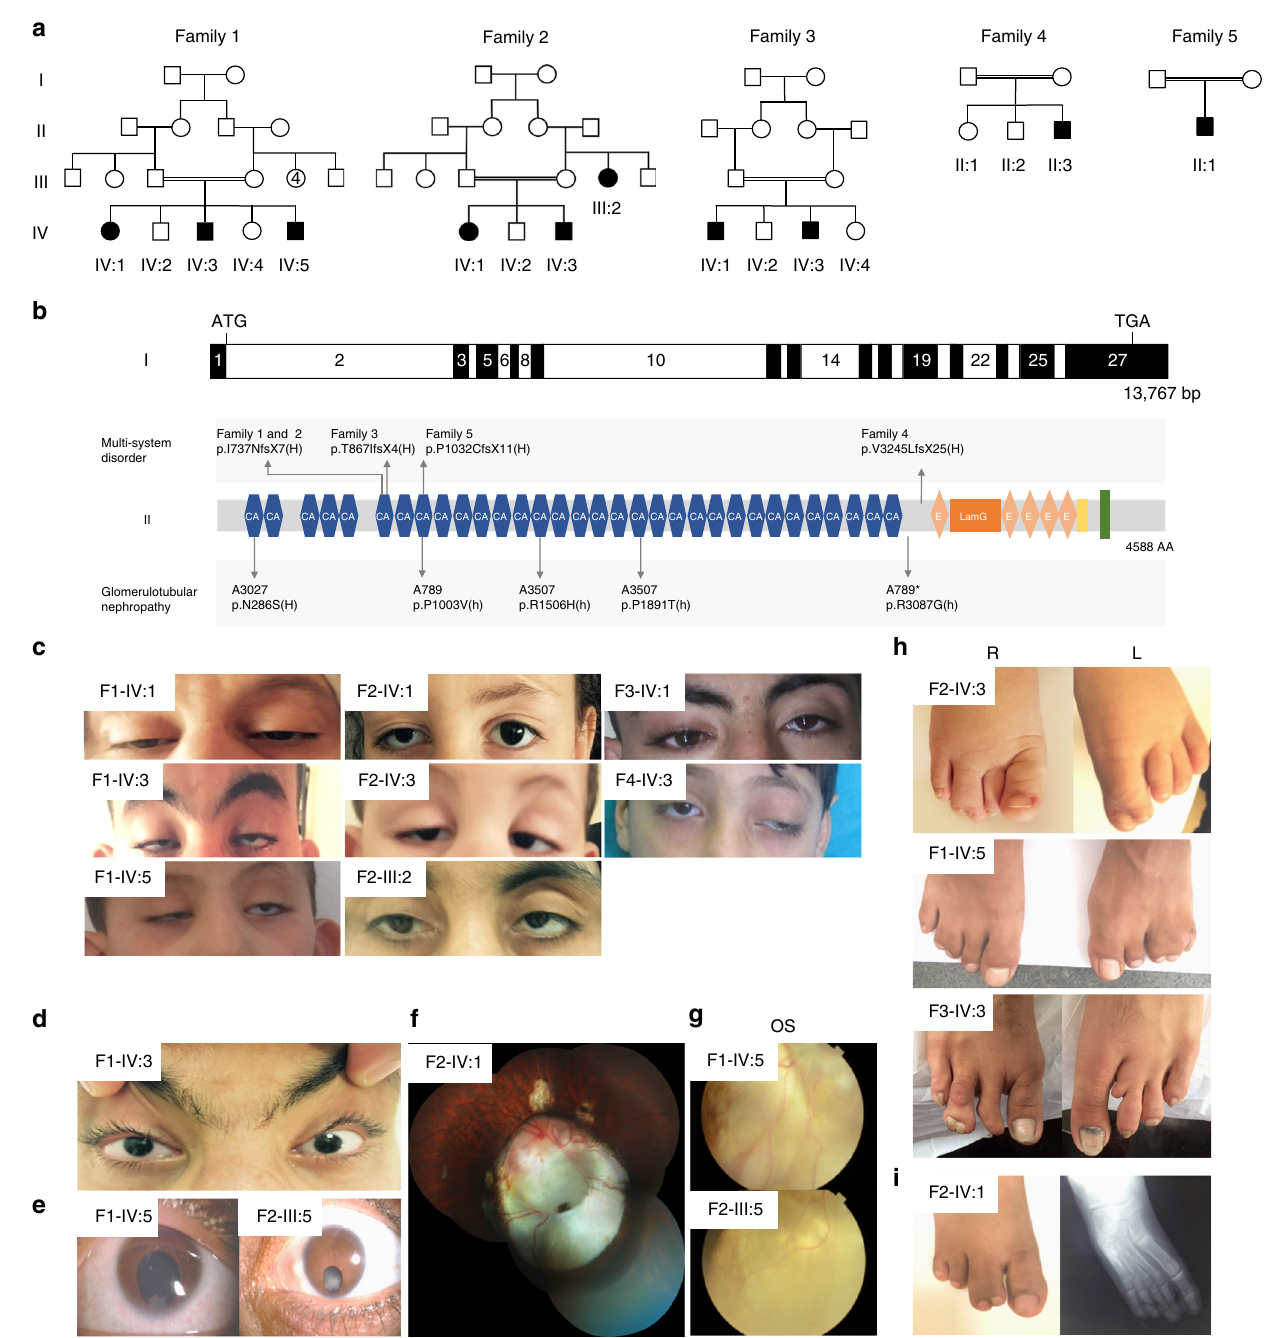
Fig. 1 Recessive frameshift mutations in FAT1 cause a new clinical syndrome. Pedigree of family 1 – 5 ( a ). A schematic of human FAT1 start/stop codon, exons, location of mutations previous published and identi fi ed in this study (top panel). The FAT1 protein is 4588 amino acids long and contains 34 cadherin repeats (CA), followed by fi ve epidermal growth factor (EGF)-like repeat domains (E), a laminin G domain (LamG), a transmembrane domain (green), and an intracellular domain (bottom panel). Family 1 and 2 were found to carry the same homozygous frameshift variant c.2207dupT (p.I737NfsX7) in FAT1 ( NM_005245). In Families 3 – 5 we identi fi ed, respectively, the following homozygous frameshift FAT1 variants: c.2600_2601delCA (p.T867IfsX4), c.9729del p.(V3245LfsX25), and c.3093_3096del (p.P1032CgsX11). H homozygous, h heterozygous ( b ). Ophthalmic features observed in patients included ptosis; bilateral in patients F1-IV-1, F1-IV-3, F1-IV-5, F2-III-3, F2-IV-3, F3-IV-1 and unilateral in F2-IV-1, F4-II-3 ( c ), microphthalmia ( d ), iris coloboma ( e ), large chorioretinal coloboma containing the papilla/optic nerve with two other smaller circumscribed chorioretinal colobomas localized above the papilla ( f ), and retinal coloboma ( g ). Skeletal abnormalities included syndactyly in the majority of patients and bone fusion of phalanges 3 – 4 on the right foot and hypotrophy of phalanx 2 of the left foot in patient F3-II-2 ( h ). X-ray of the feet demonstrating cutaneous syndactyly in patient F2-IV-1 ( i )